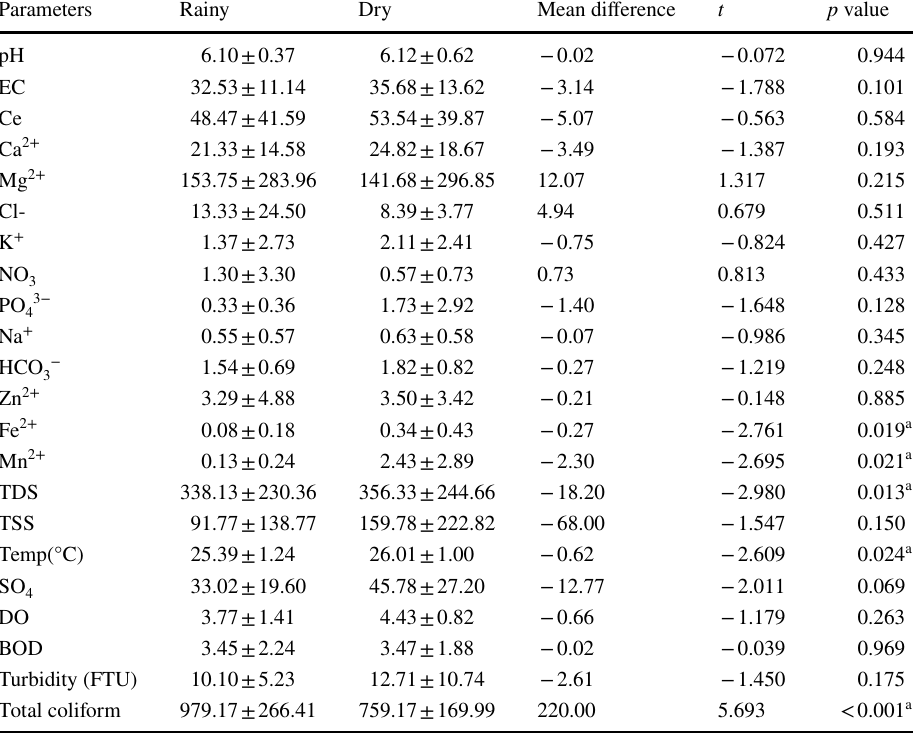
Statistics used: paired samples t test a Parameters with